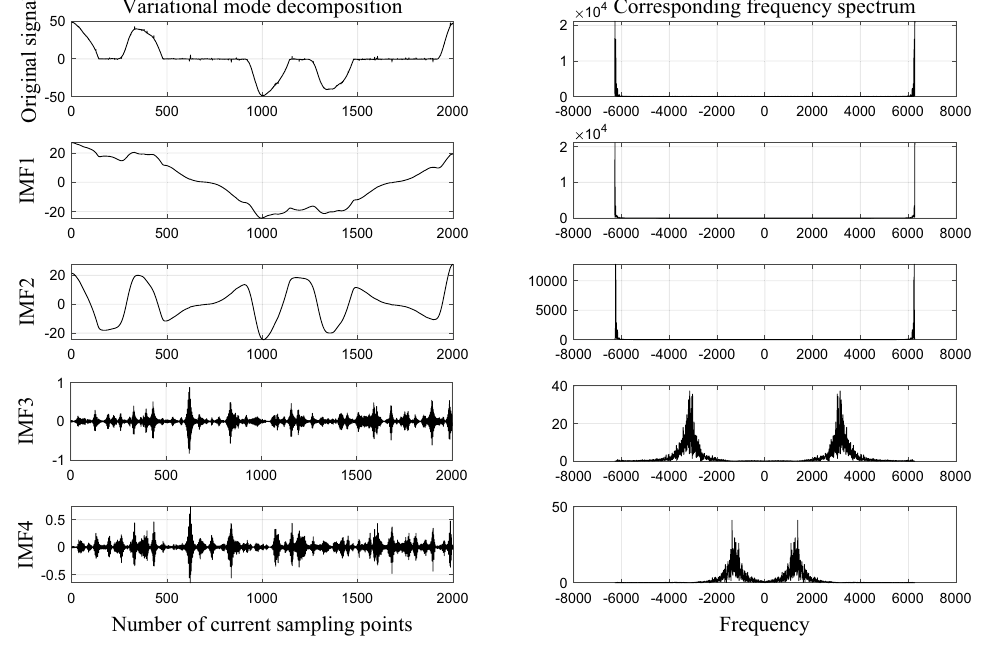
Figure 4. The result of VMD in normal state.